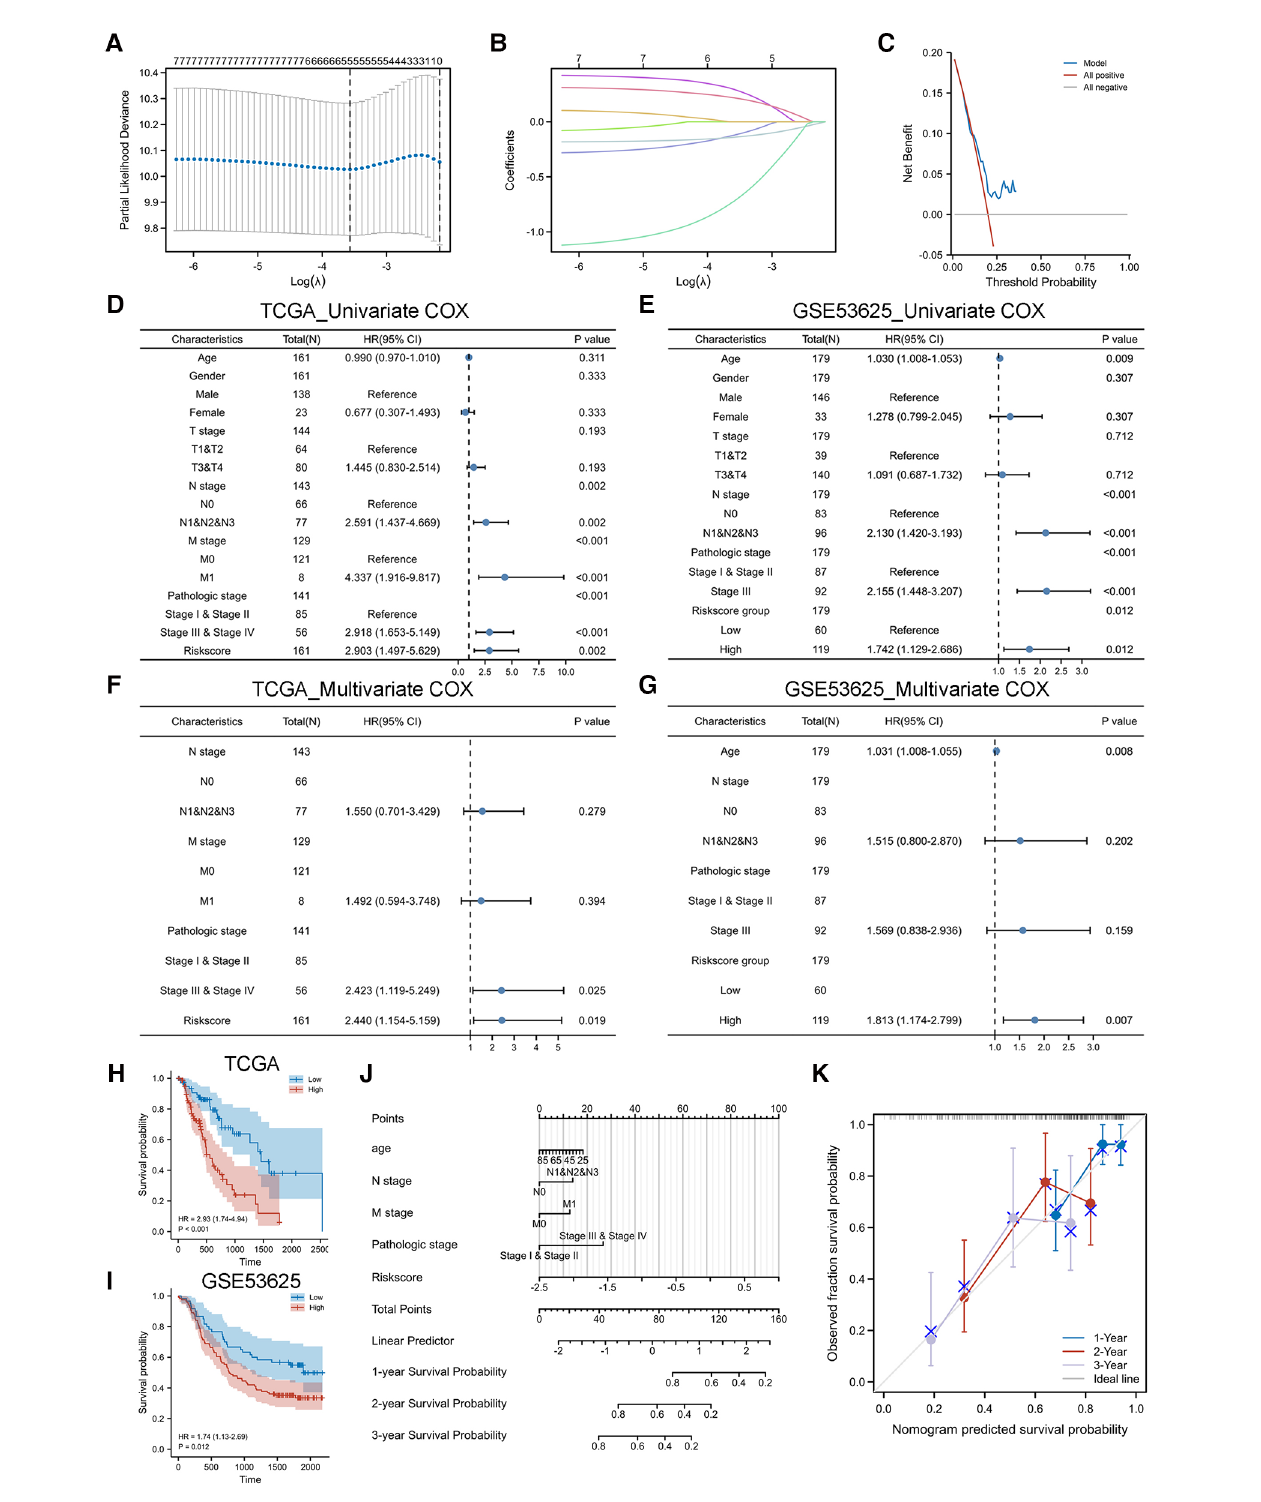
FIGURE 3 Construction and validation of CSRS nomogram model. ( A,B ) Five genes were identi fi ed as CS-related prognostic hub genes by lasso algorithm, including IGFBP1, H3C1, SOX5, CDHR4 and MT1E. ( C ) DCA chart con fi rmed the prognostic utility of CSRS. ( D-G ) Univariate and multivariate Cox regression analyses of OS in TCGA-ESCA. Validation is performed by GSE53625. ( H-I ) KM curves of OS in TCGA-ESCA and GSE53625. ( J ) Nomogram model to predict the 1-,2- and 3-year survival of EC patients. ( K ) Calibration curves for evaluating. The fi t is around the diagonal and the C-index value is 0.744, indicating good consistency of the